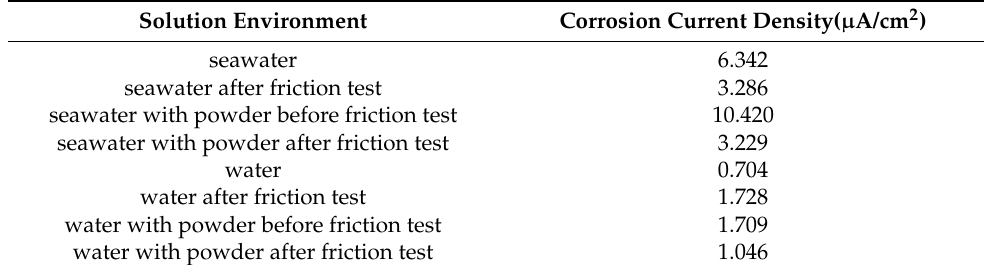
Table 9. Comparison of the corrosion current density with and without PA66 powder before and after friction and wear tests.